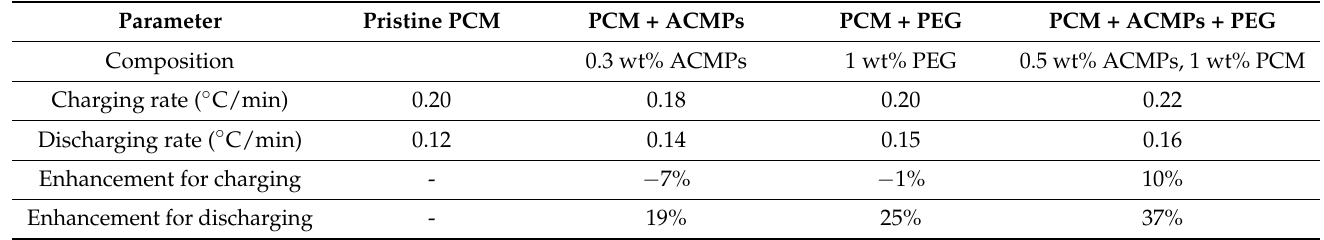
Table 2. Enhancement of charging and discharging rates of phase change material (PCM) with